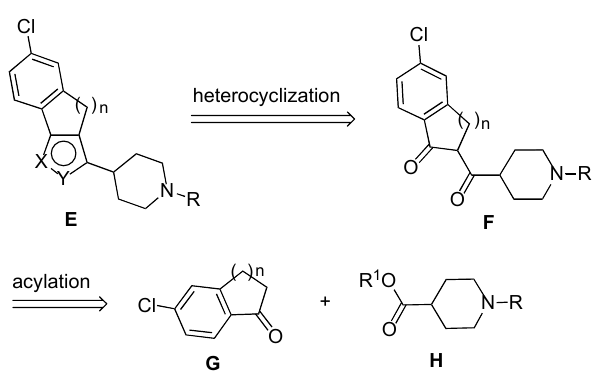
Scheme 1. Retrosynthesis